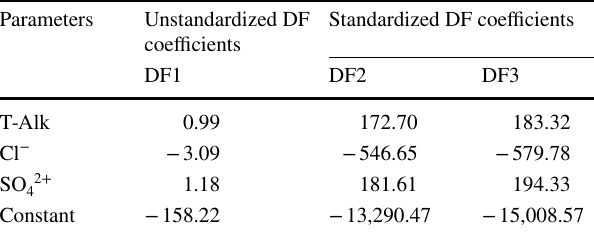
Table 3 Stepwise discriminant function coefficients Parameters